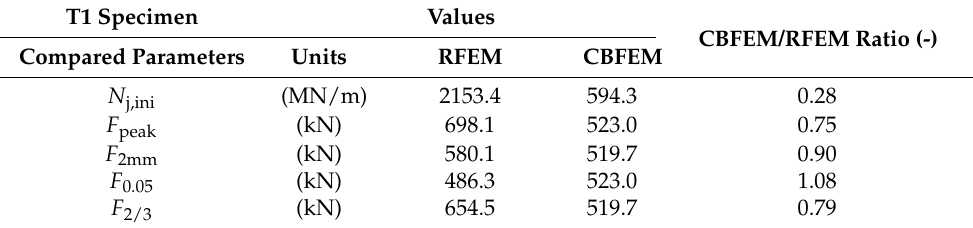
Table 4. Comparison of CBFEM and RFEM models for specimen T1. T1 Specimen